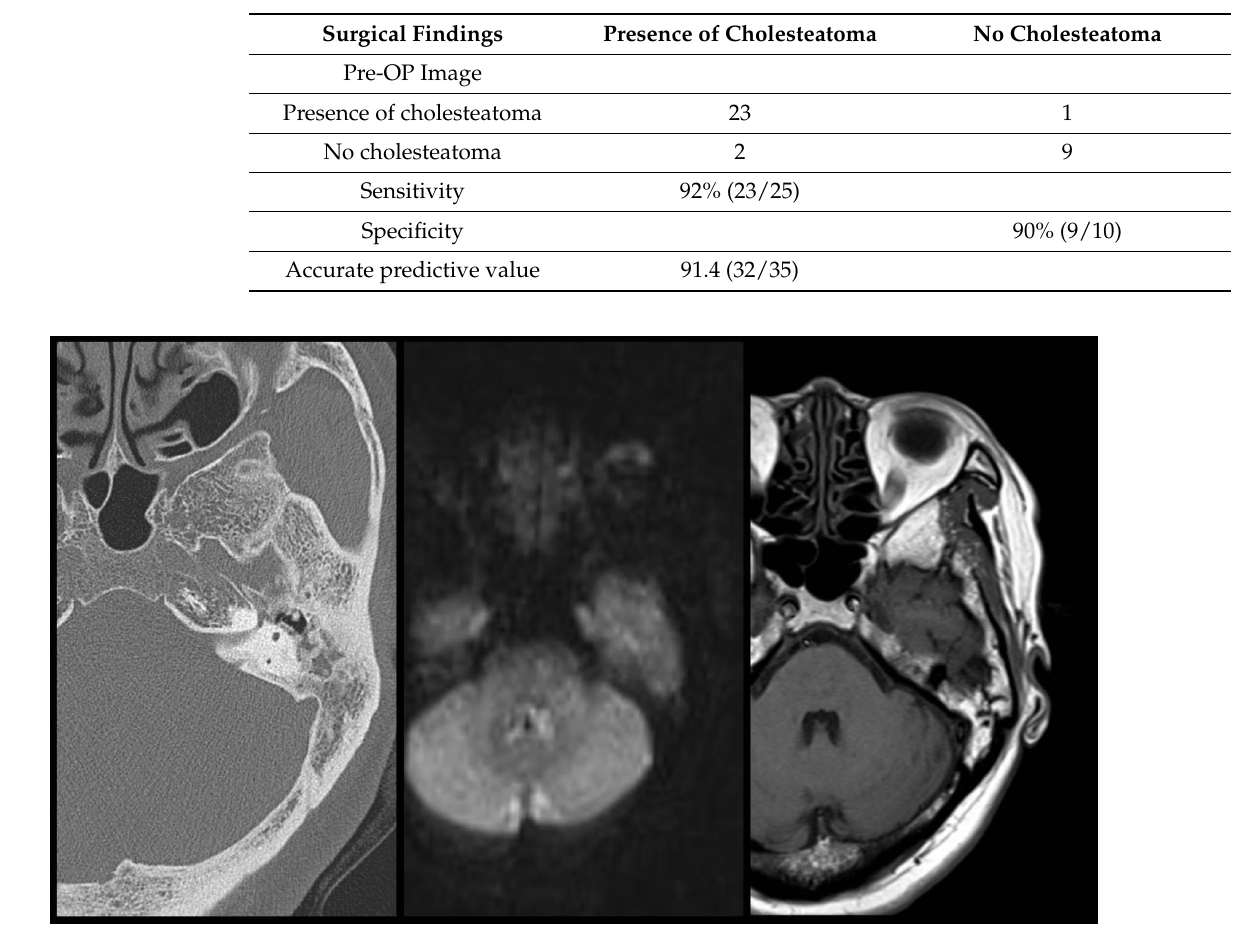
Table 3. The accuracy of preoperative DW-T1W-CT estimate on the extent of cholesteatoma.